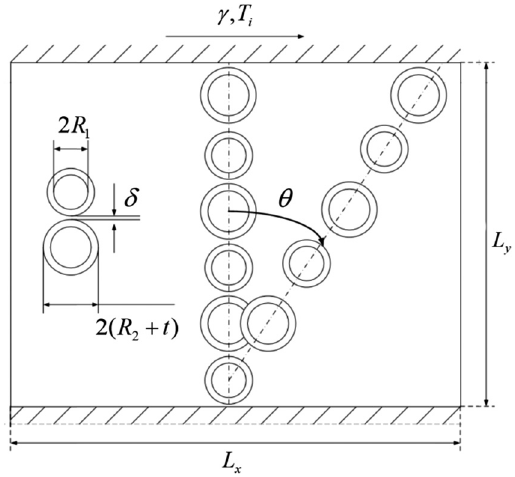
Figure 3: Sketch of the deformation of a stretched single